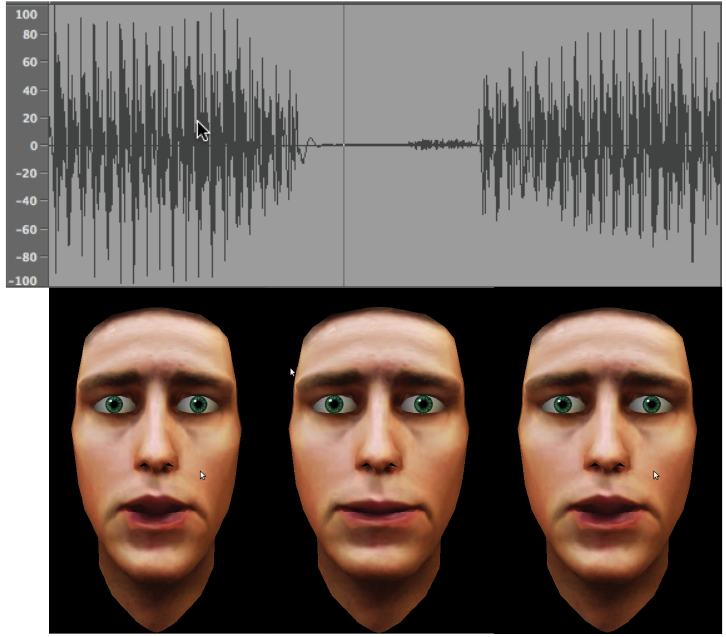
Figure 17. Synthetic speech: / atSa